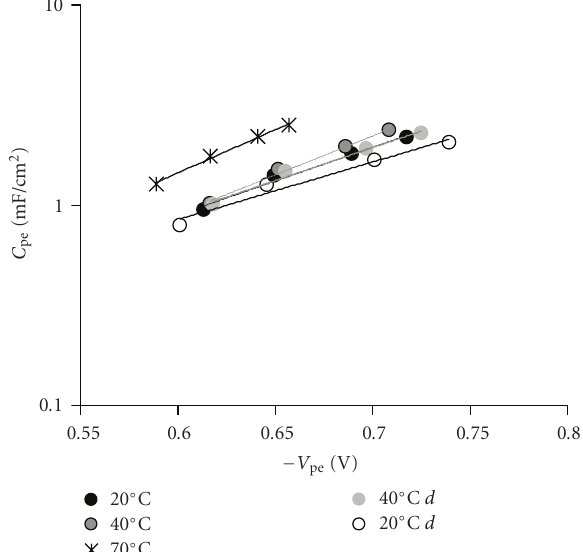
Figure 10: Photoelectrode capacitance as a function of photo- electrode voltage, at di ff erent temperatures; second set of EIS measurements. Letter “ d ” after the temperature value indicates the downward sweep of the temperature